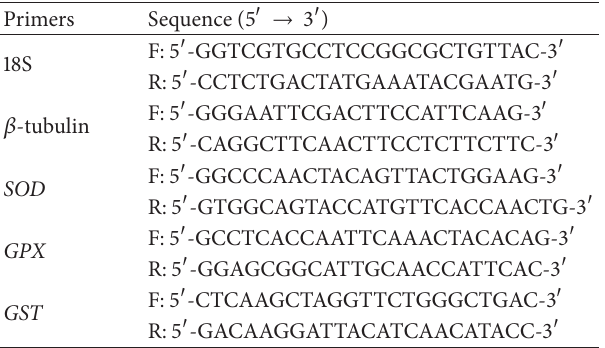
Figure 2: Effects of inoculation stage and medium exchange period on plantlet conversion of bioreactor cultured germinated SEs of Siberian ginseng after culturing on 1/3 MS medium for 2 months. Values with different letters in a column are significantly different according to Duncan’s multiple range test at the 5% level. Table 1: Primers used for quantification of antioxidant enzyme genes by real-time